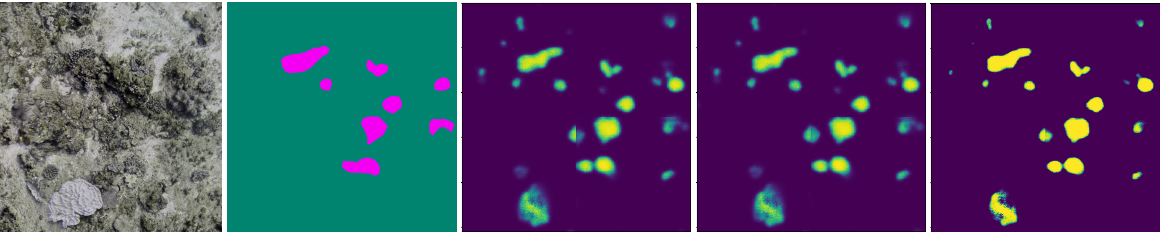
Figure 8. (From Left to Right) Input image. Manually annotated labels. Classification scores without aggregation. Average scores. Bayesian Fusion.